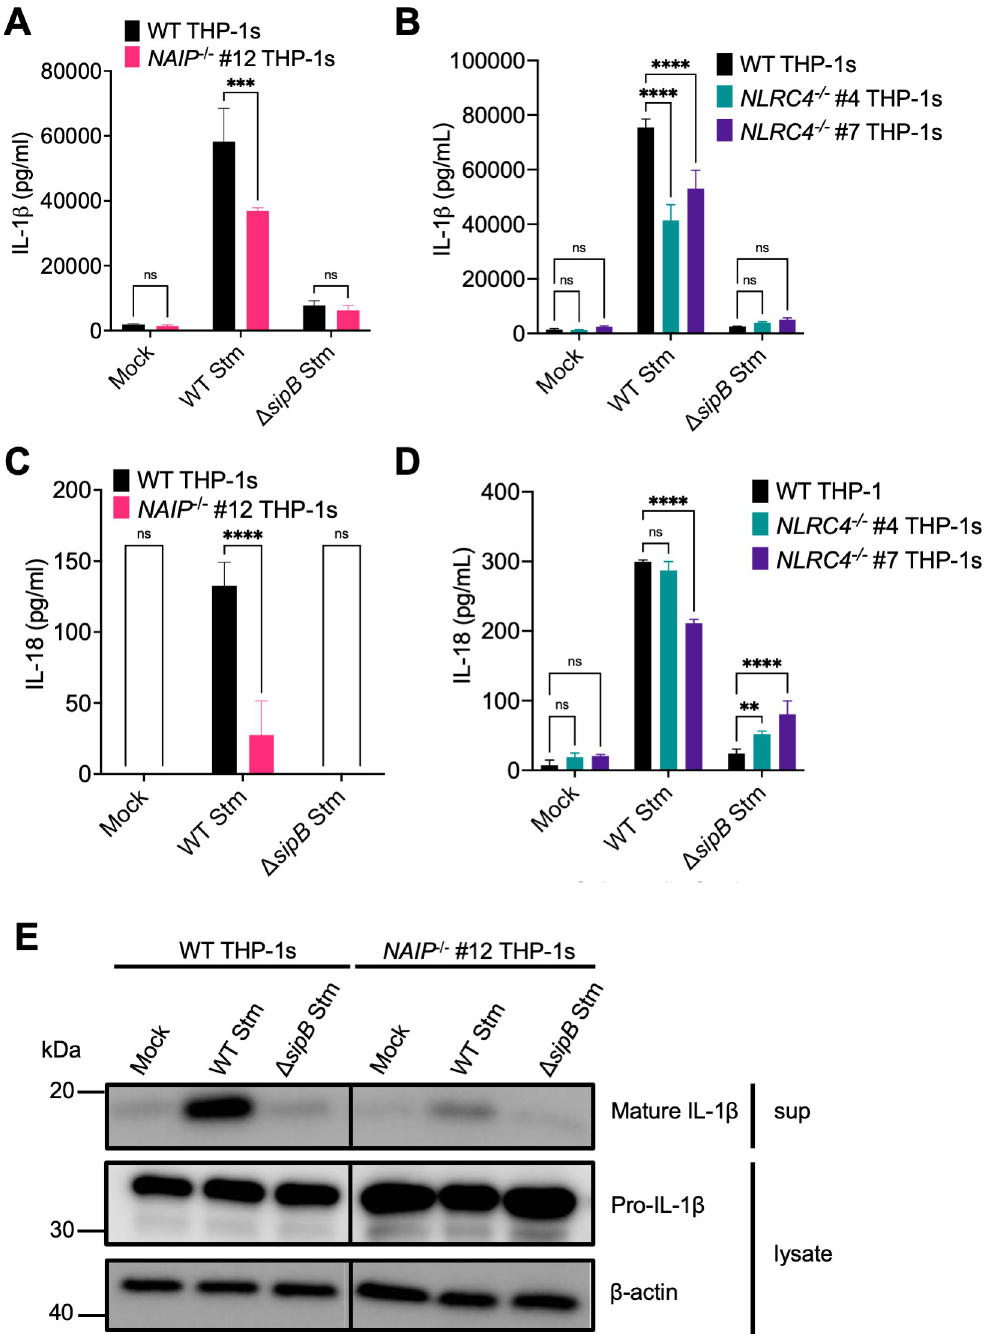
Fig 2. NAIP and NLRC4 are partially required for inflammasome activation during Salmonella infection in human macrophages. WT, NAIP -/- clone #12, and two independent clones of NLRC4 -/- THP-1 monocyte-derived macrophages were primed with 100 ng/mL Pam3CSK4 for 16 hours. Cells were then infected with PBS (Mock), WT S . Typhimurium, or Δ sipB S . Typhimurium at an MOI = 20 for 6 hours. Release of IL-1 β (A, B) and IL-18 (C, D) into the supernatant were measured by ELISA. Immunoblot analysis was performed on supernatants (sup) for mature IL-1 β and on lysates for pro– IL-1 β and β -actin as a loading control. ns–not significant, ��� p < 0.001, ���� p < 0.0001 by S ˇ ı´da´k’s multiple comparisons test (A, C) or Dunnett’s multiple comparisons test (B, D). Error bars represent the standard deviation of triplicate wells from one experiment. Data shown are representative of at least three independent experiments.